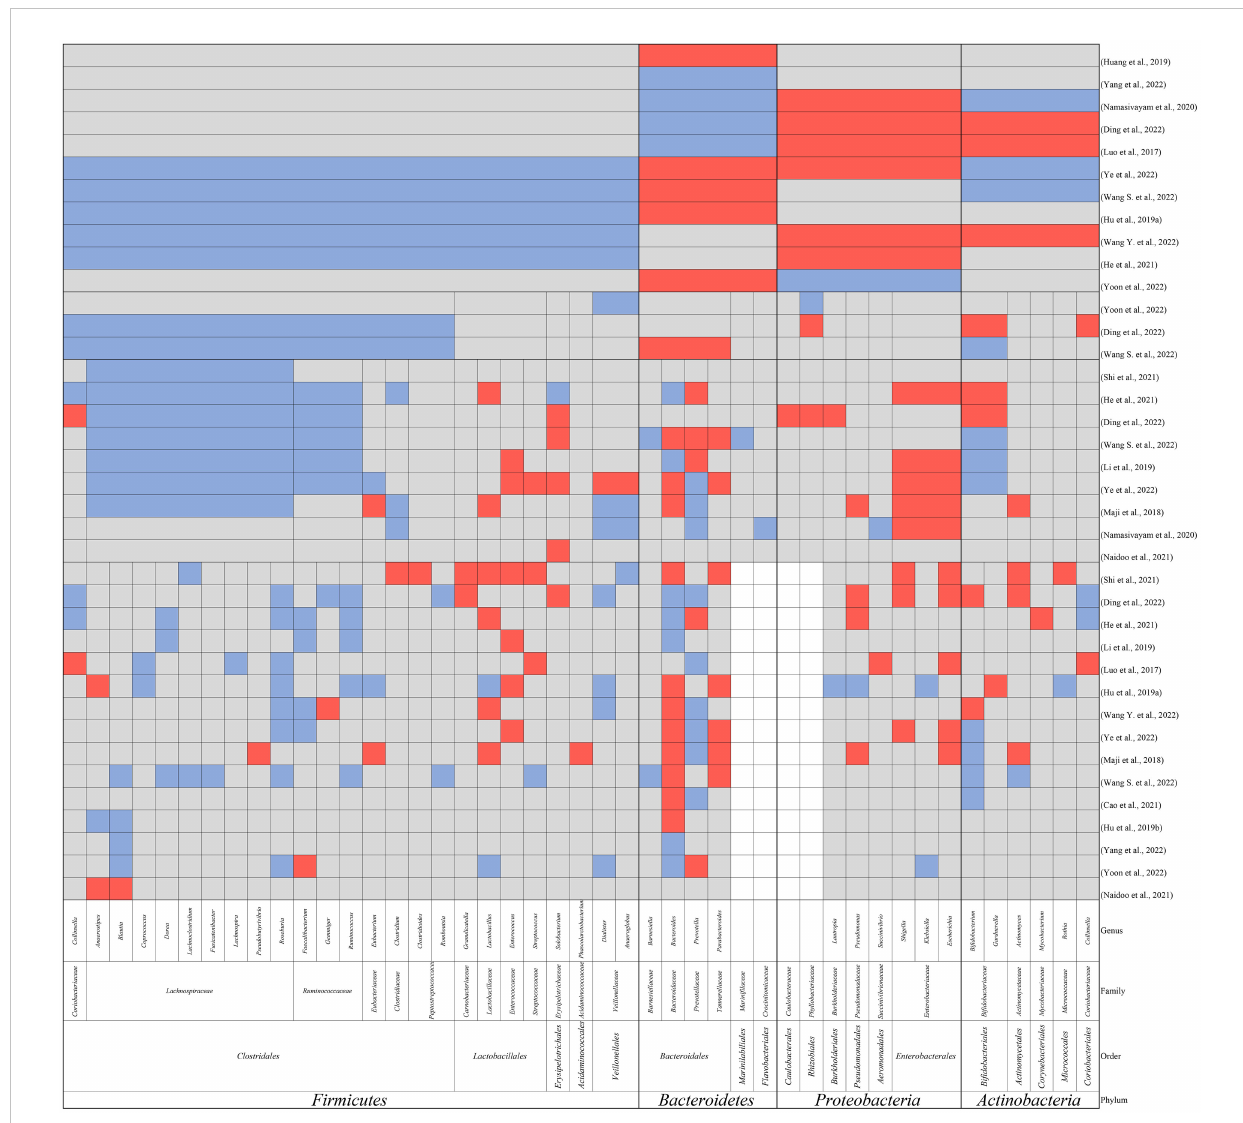
FIGURE 1 The main fi ndings in alteration of gut microbiomes in TB patients compared to healthy controls at the phylum, order, family, and genus level. Red: elevation; blue: reduction; grey: not reported; white: no reported genus within the